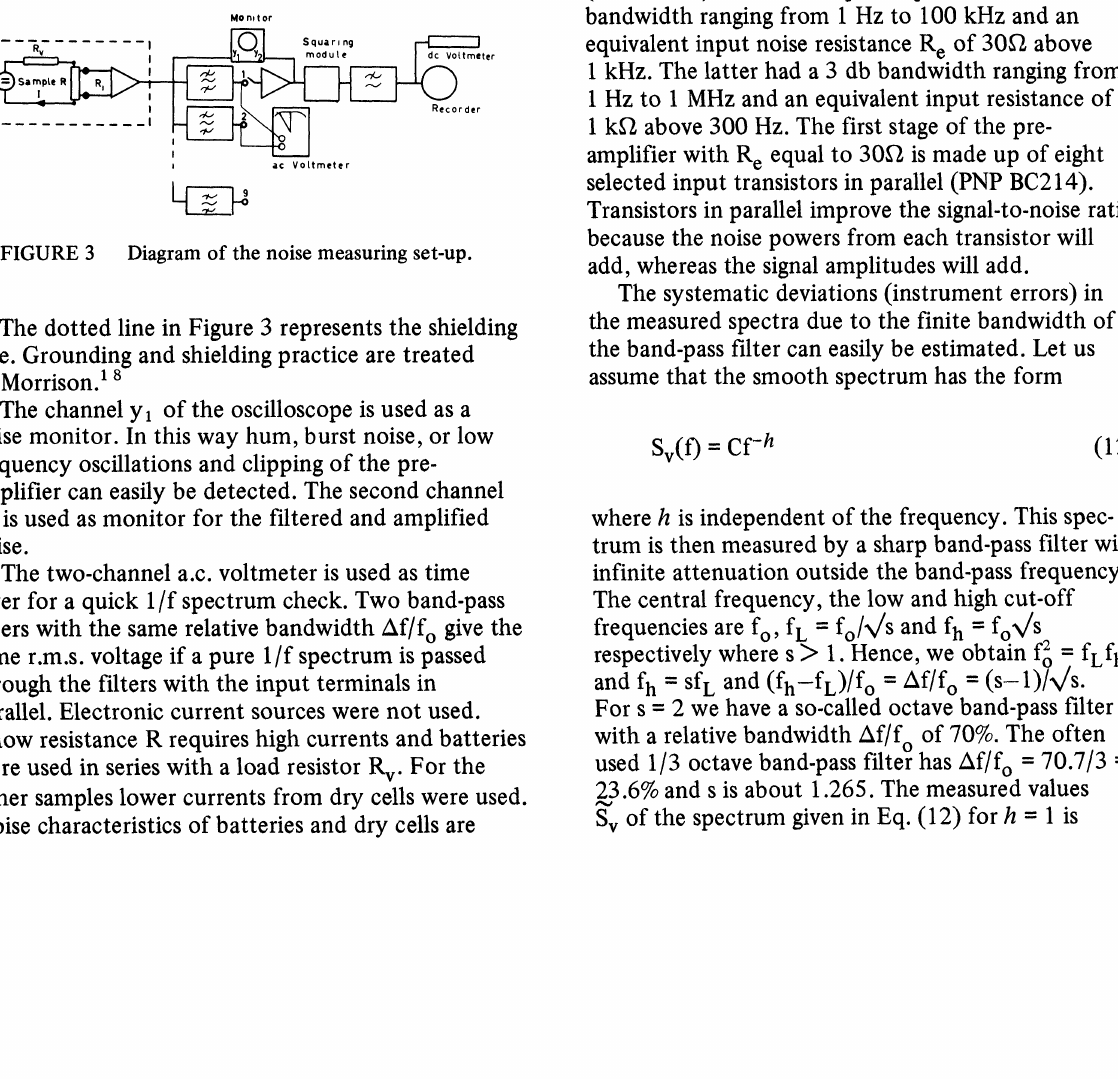
Diagram of the noise measuring